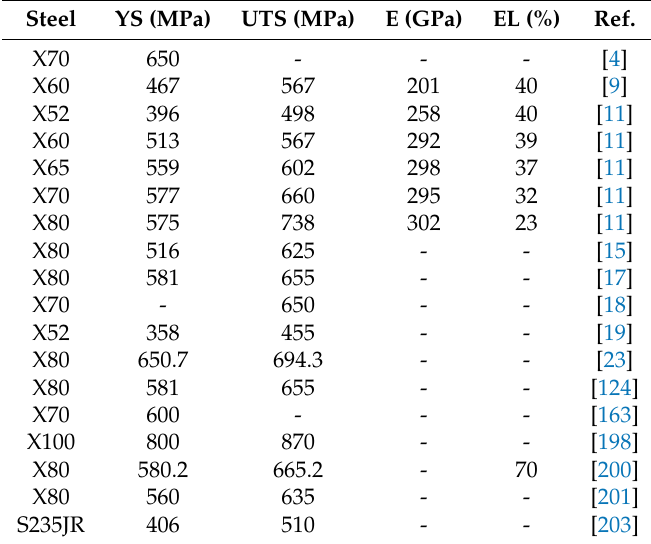
Table 4. Reviewed mechanical properties for external corrosion studies.